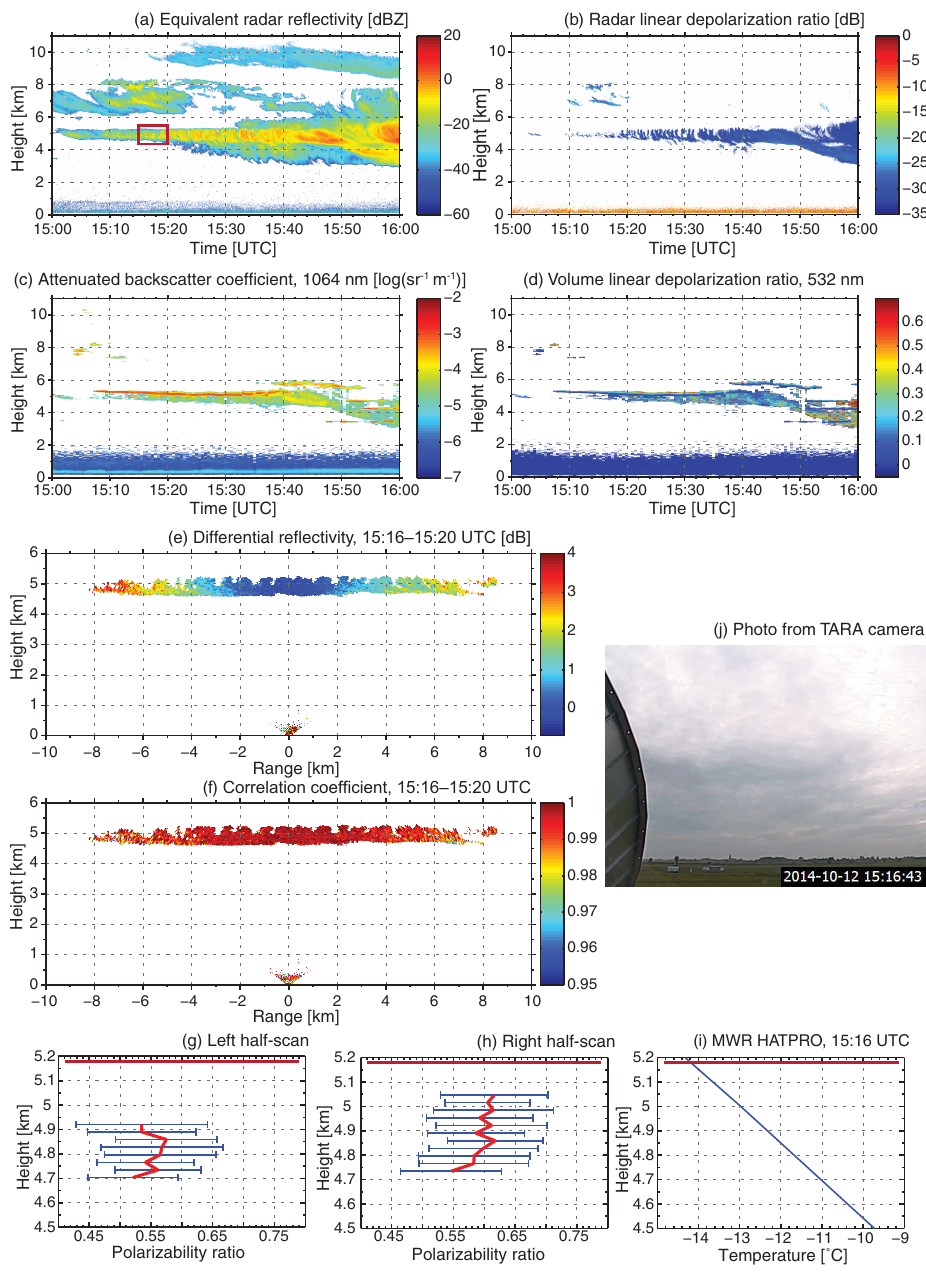
Figure 3. Case study of ice crystal shapes observed with hybrid-mode MIRA-35 on 12 October 2014 at Cabauw, the Netherlands. Shown are time–height cross sections of the following parameters: (a) equivalent radar reflectivity Z e from LDR MIRA-35; (b) radar linear depolariza- tion ratio from LDR-mode MIRA-35; (c) attenuated backscatter coefficient at 1064nm from Polly-XT; and (d) volume linear depolarization ratio at 532nm from Polly XT . Range–height cross sections of (e) differential reflectivity Z DR and (f) correlation coefficient ρ HV measured by hybrid MIRA-35. (g, h) Vertical profiles of polarizability ratio for the left and right half-scans. (i) Vertical temperature profile from the microwave radiometer HATPRO. (j) Photo taken by a web camera installed at the CESAR site. The red rectangle shows the analyzed cloud layer and the time period corresponding to a full elevation scan of hybrid-mode MIRA-35. Z e and LDR were calculated from total powers in the co- and cross-channels. Z DR and ρ HV were obtained for the spectral peaks. Note that Z DR and ρ HV are not corrected for the antenna coupling here to make figures more illustrative. Red horizontal lines in (g, h, i) represents the cloud top. Vertical profiles in (g) and (h) indicated by red lines correspond to mean values of polarizability ratio. Horizontal blue bars in (g) and (h) denote 2 standard deviations of polarizability